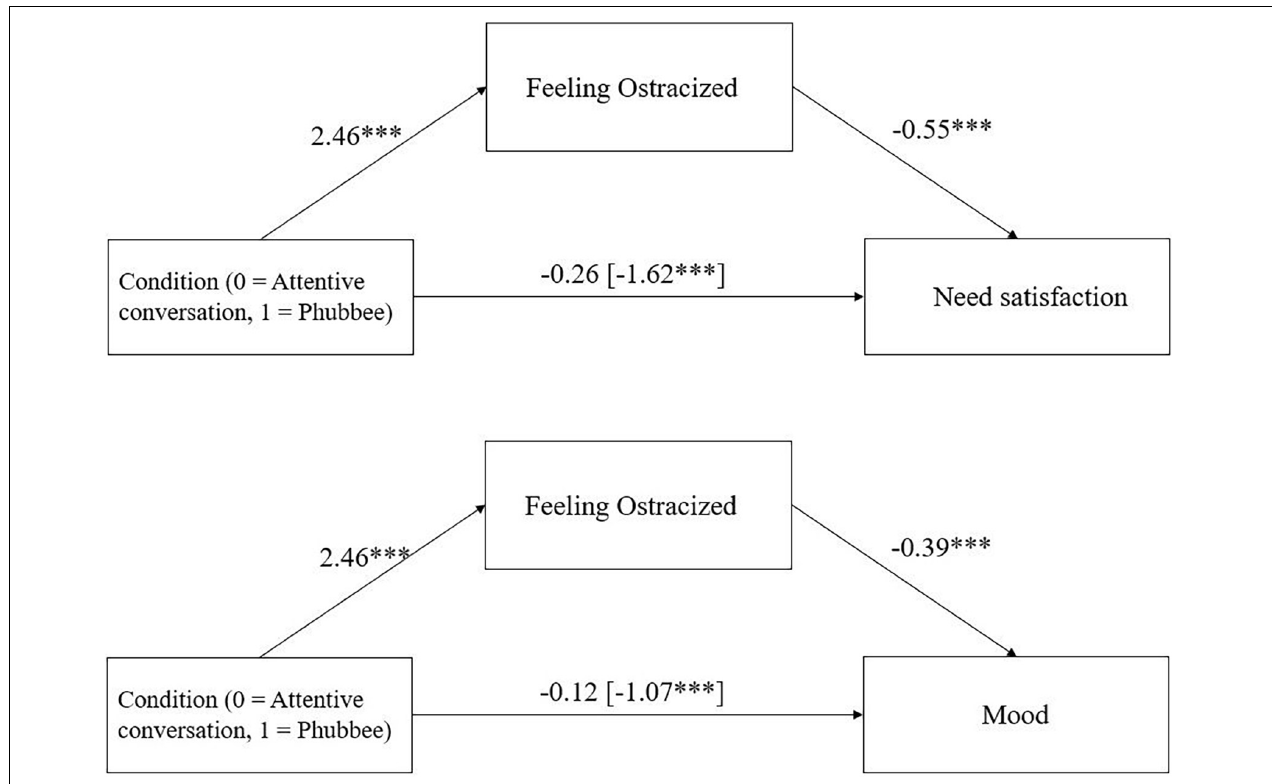
FIGURE 1 | Mediation effect of condition (attentive conversation vs. phubbee) via feelings of ostracism on need satisfaction and mood in Study 1 including the direct effect of condition on need satisfaction and mood (with total effect in parentheses). ∗ p < 0.05, ∗∗ p < 0.01, ∗∗∗ p < 0.001.